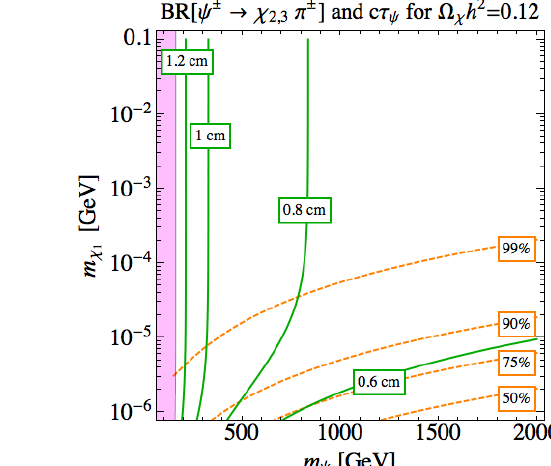
(solid lines) and (cid:31) (dashed lines). Right: 2 3 (cid:6) ; the 2 ; 3 (cid:25)